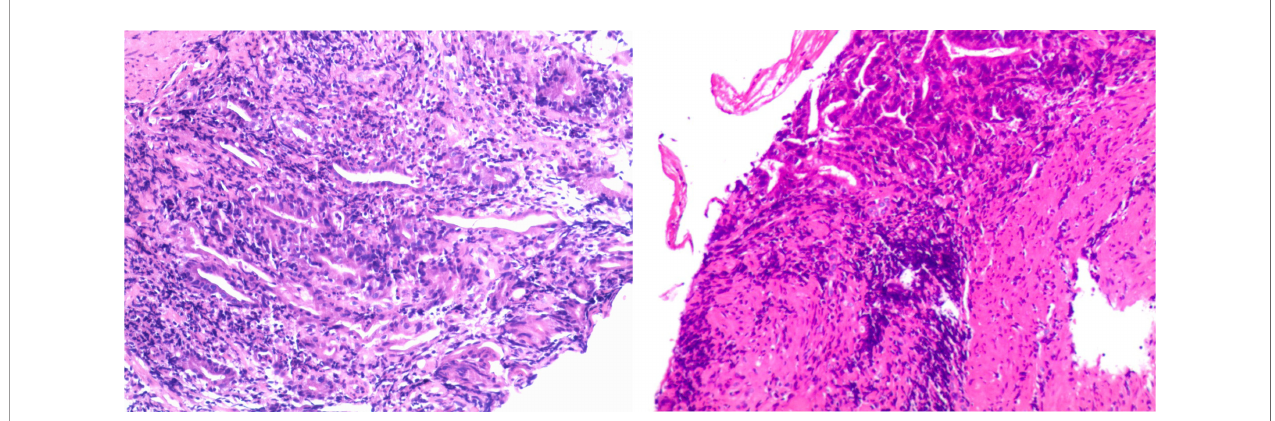
FIGURE 3 | Pathologic fi ndings of the biopsy specimen showed severe atrophic gastritis with erosion, atrophy, and loss of intrinsic glands; focal aggregation of lymphocytes in the lamina propria and mucosal muscular layer; multiple neutrophil in fi ltration; and the formation of